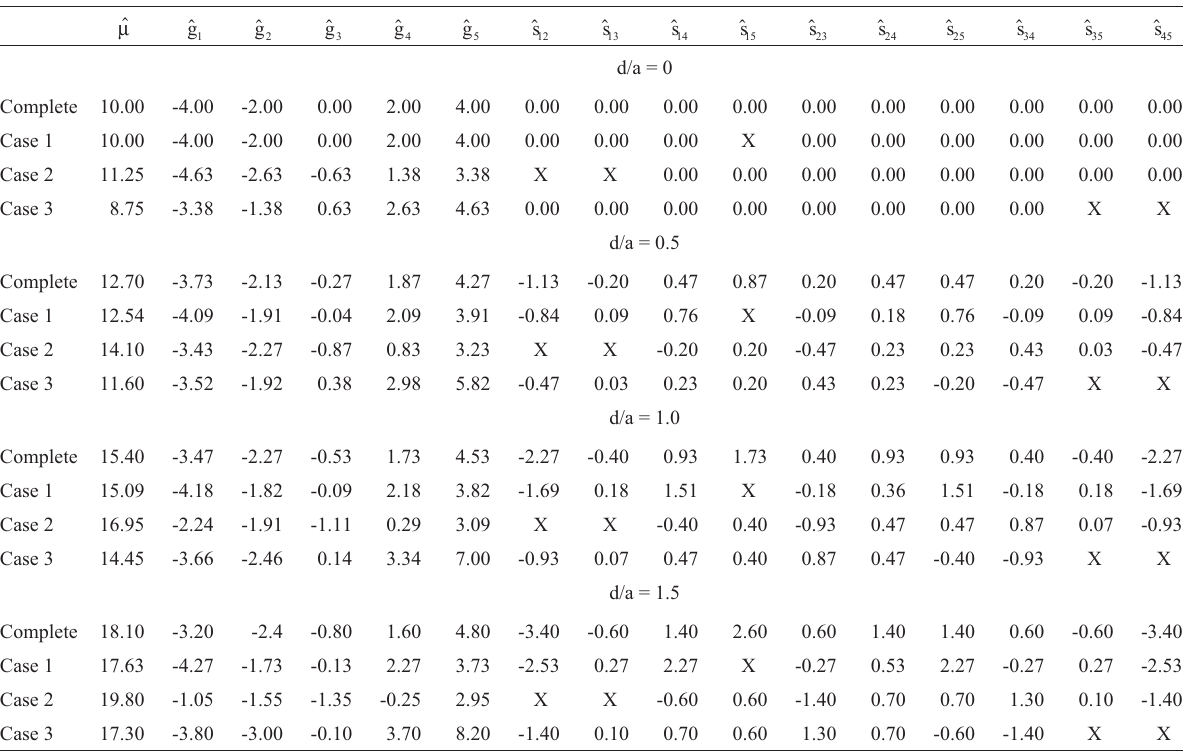
Table 7 - Estimates of the parameters of the complete and incomplete diallel models for Cases 1, 2 and 3 (constraints c g and considering different average degrees of dominance.